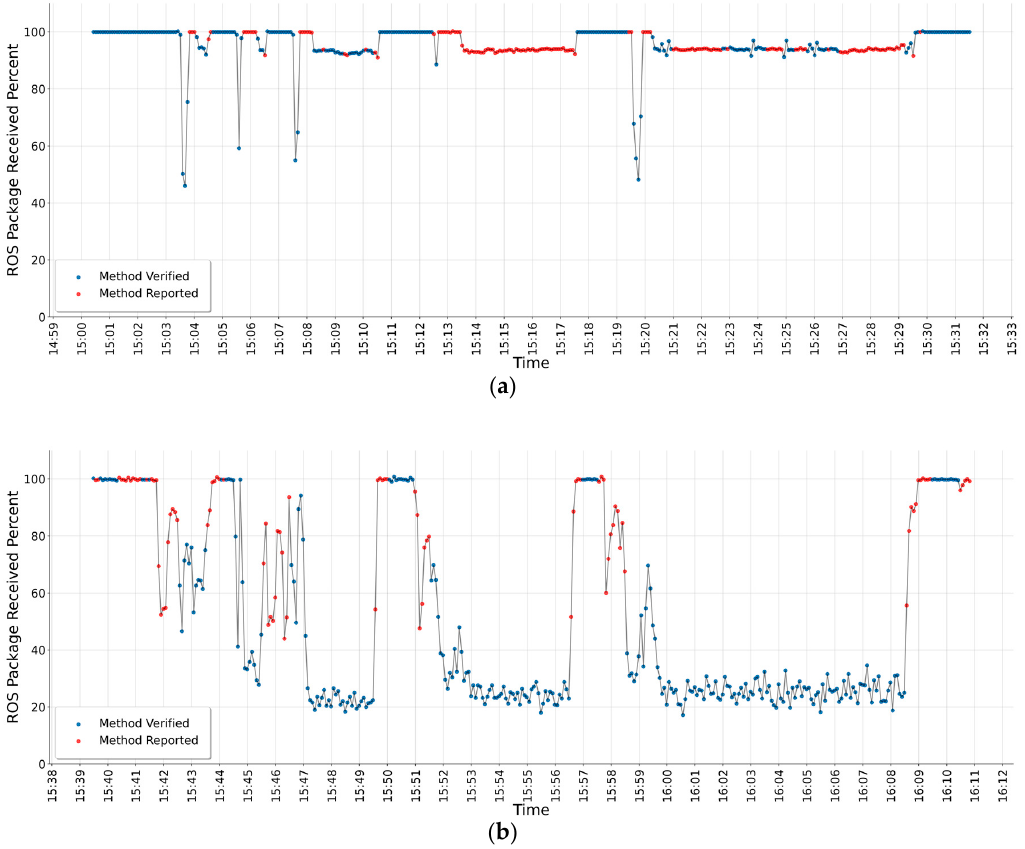
Figure 5. Test results of runtime verification method where ROS running in different volume of traffic: ( a ) 500 nodes traffic; ( b ) 1000 nodes traffic. traffic: ( a ) 500 nodes traffic; ( b ) 1000 nodes